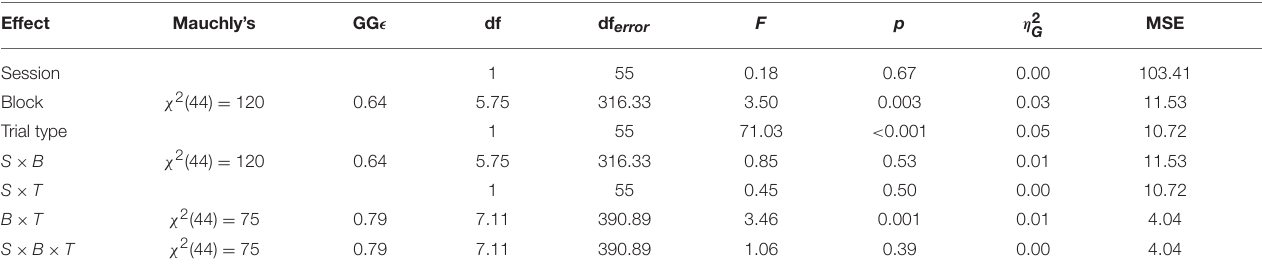
TABLE 5 | Analysis of variance for ASRT with proportion correct as dependent measure. Effect